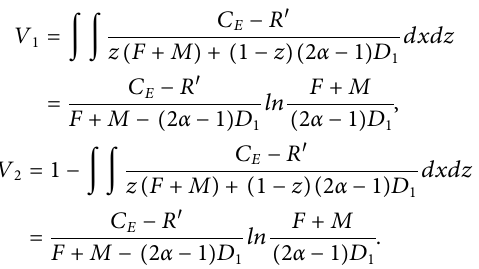
Figure 2 indicates that volume V 1 on the left side of y 0 represents the probability that MEs choose negative governance, whereas V 2 on the right side of y 0 represents the